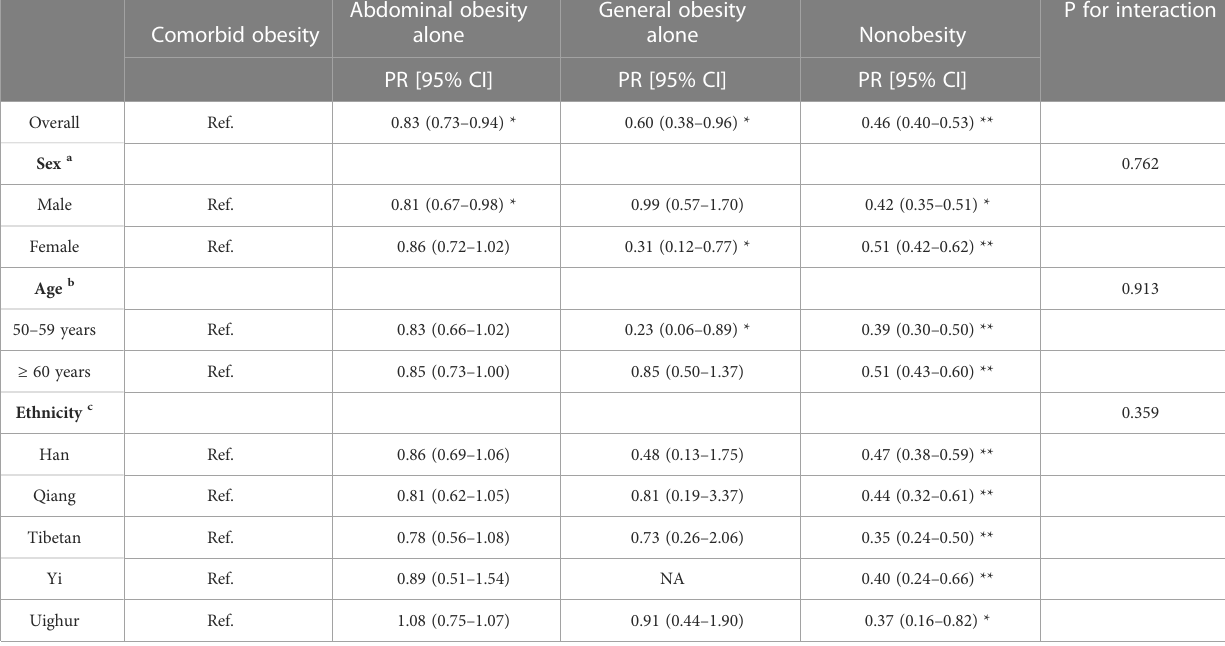
TABLE 3 Associations of obesity subgroups with fasting hyperglycemia in the adjusted model.